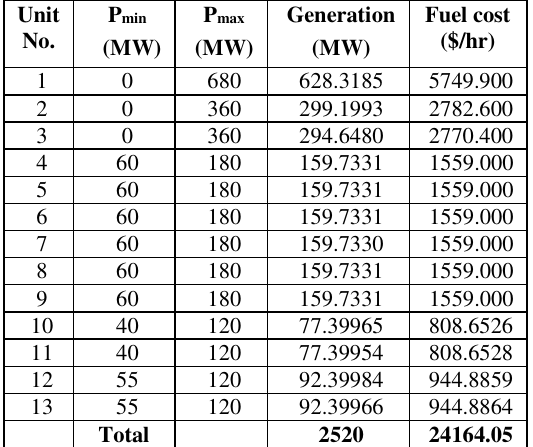
TABLE A3: OPTIMAL GENERATIONS FOR TEST CASE